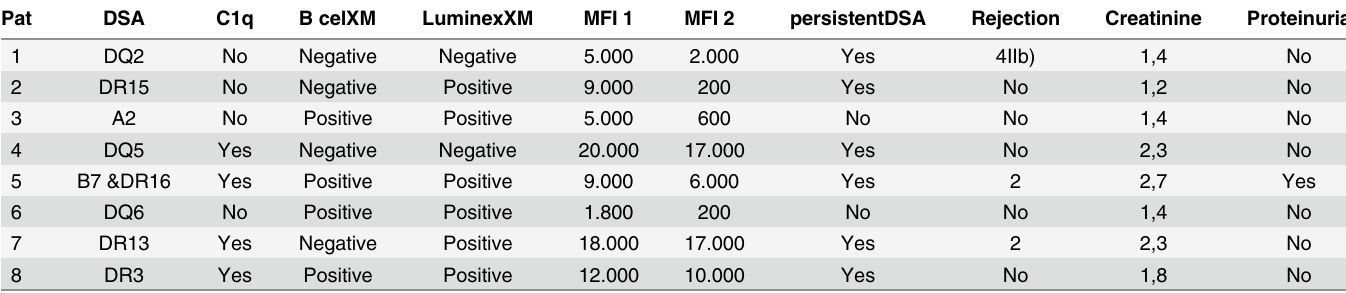
Table 3. Immunologic characteristics in the DSA group. Pat